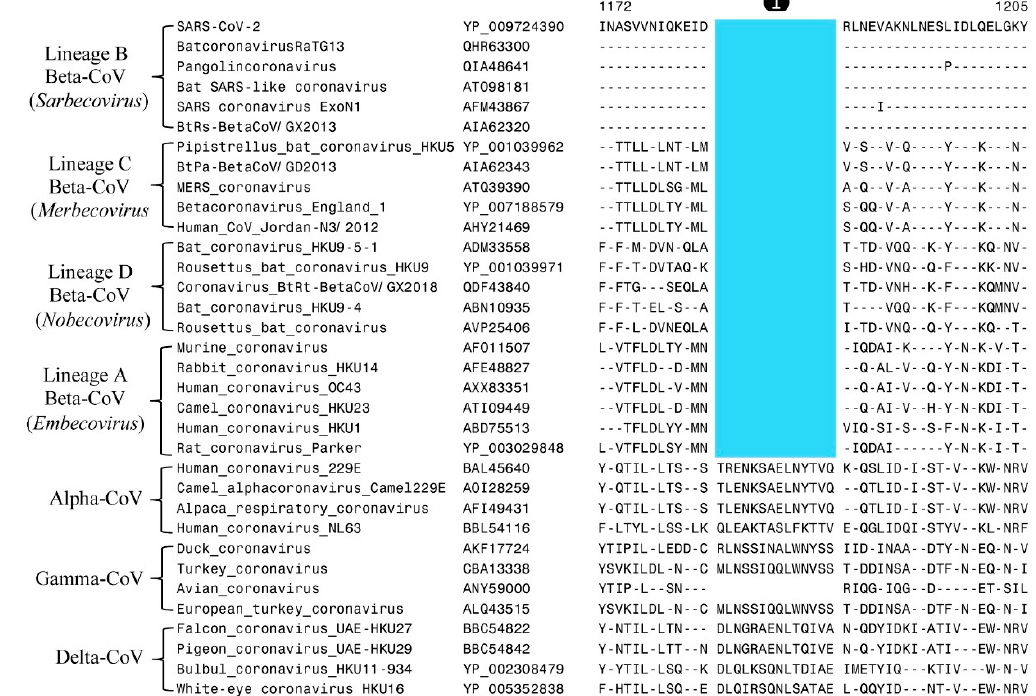
Figure 2 . Partial sequence alignments of two conserved regions from the spike protein showing two different CSIs that are specific for the genus Betacoronavirus . The CSIs present in these sequence alignments are highlighted in blue and they are labeled ❶ and ❷ . Both CSIs are commonly shared by all members of the genus Betacoronavirus , but barring one exception, avian coronavirus, they are not found in any other CoV. Dashes (–) in these and all other sequence alignments denote identity with the amino acid shown in the top sequence. The numbers on the top indicate the locations of these sequence regions within the indicated proteins. The accession numbers of different proteins are given in the second column.